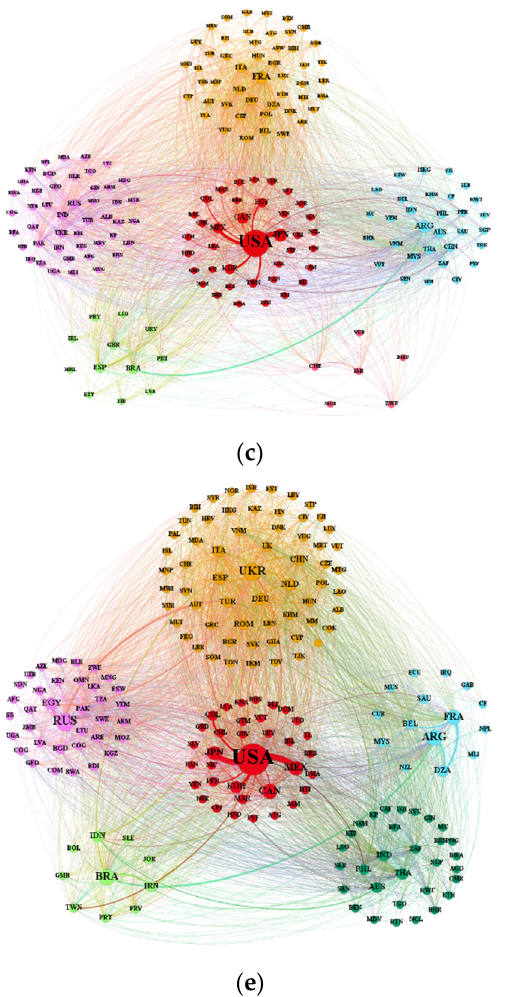
Figure 5. Community structure and flow patterns in the global food trade. ( a ) 1994; ( b ) 2000; ( c ) 2006; ( d ) 2012; and ( e ) 2018. The same color indicates the same trade community. The thicker and larger the lines and dots, the greater the scale of export quantity. The name of the country is briefly processed to facilitate the identification and recognition of the country. In ( a ), red is the USA-JPN community, light green is the CHN-KOR community, yellow is the FRA community, purple is the CAN community, blue is the AUT community, dark green is the ARG community. In ( b ), red one the USA community, blue is the CAN-AUS community, yellow is the FRA community, purple is the ARG community, dark green is the CHN-KOR community. In ( c ), red is the USA community, yellow is the FRA community, blue is the ARG–AUS community, purple is the RUS community, light green is the BRA-ESP community, pink is the ISR community. In ( d ), red is the USA community, purple is the FRA community, dark green is the ARG-BRA community, blue is the UKR-ESP community, light green is the AUS community, yellow is the ISR-CHE community. In ( e ), red one the USA-JPN community, yellow is the UKR-ESP community, purple is the RUS community, blue is the ARG-FRA community, dark green is the THA-IND community, light green is the BRA-IRN community.